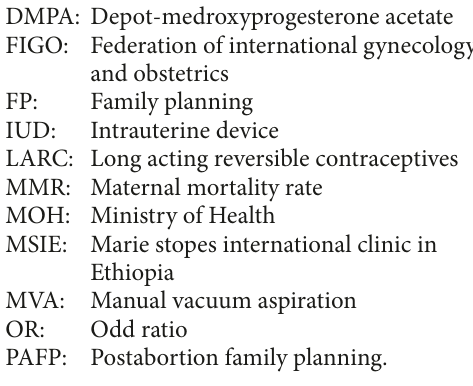
FIGO: Federation of international